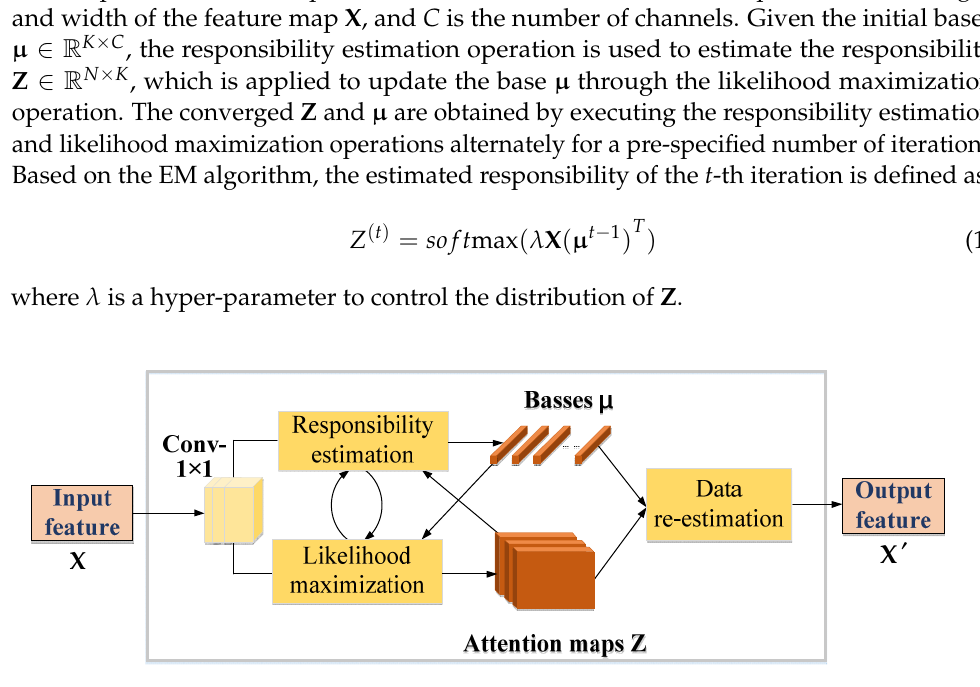
Figure 5. EMA structure diagram.